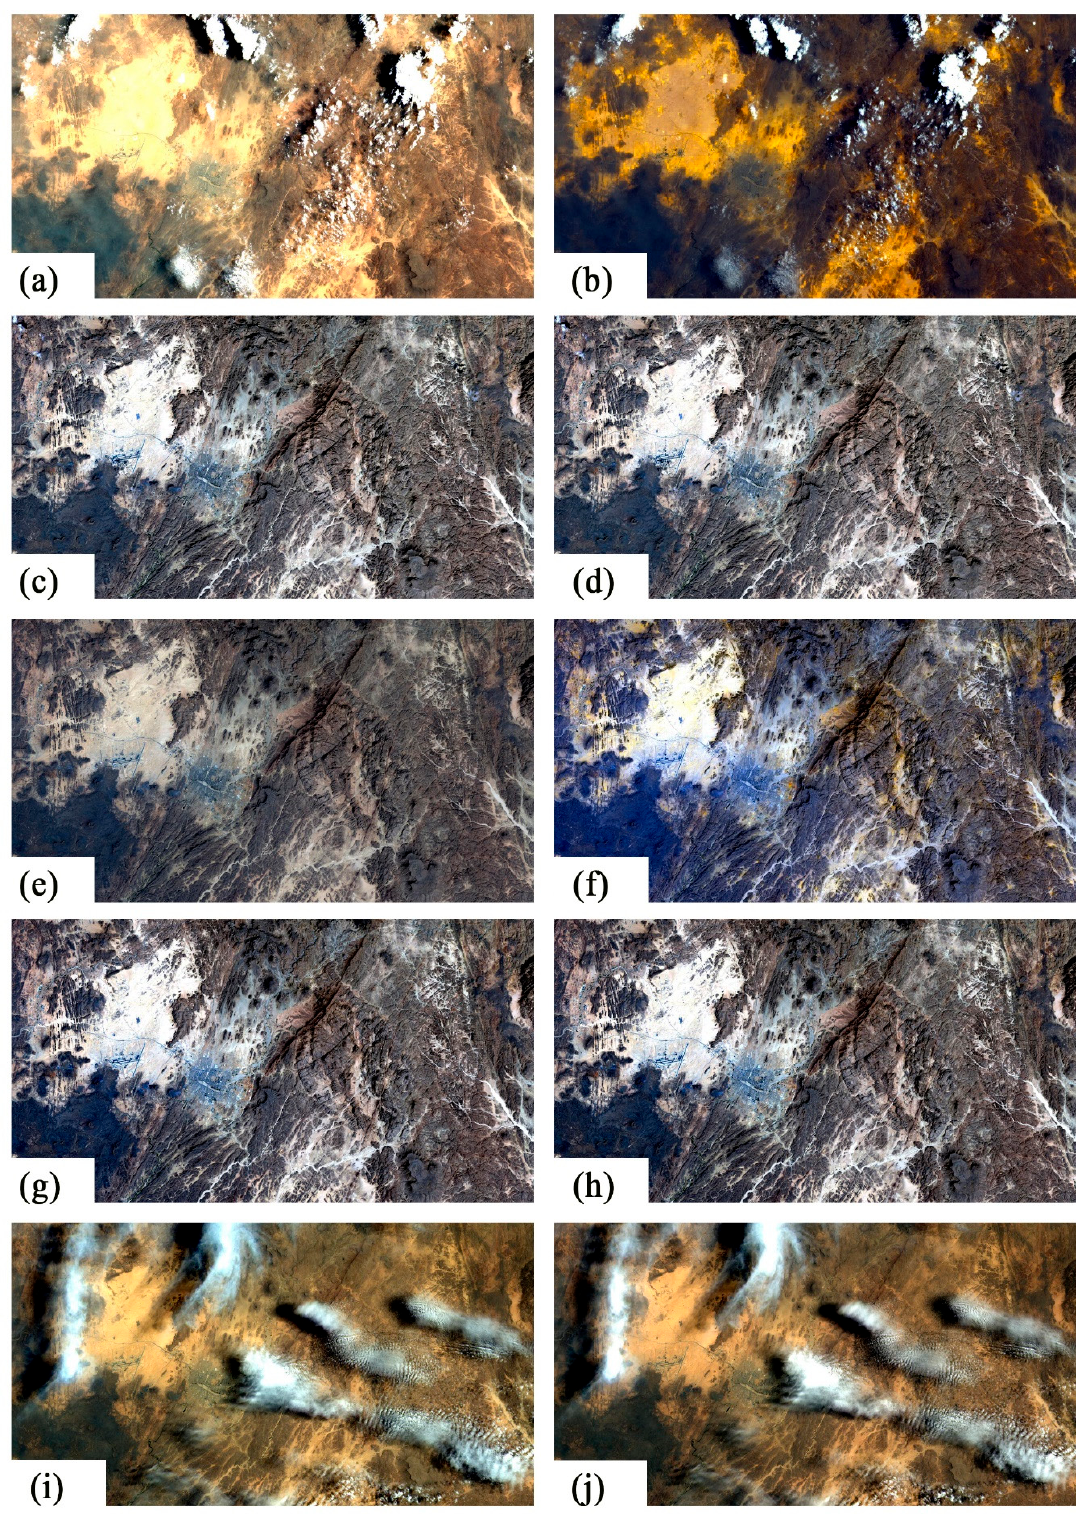
Figure 5. The atmospheric correction example for multi-temporal Landsat8 / OLI imagery at Tamanrasset_INM site. The left column is the true color composite before atmospheric correction. The right column is the true color composite after atmospheric correction. The dates of these images from top to bottom respectively are ( a , b ) 29 May 2015, ( c , d ) 1 December 2016, ( e , f ) 19 February 2017, ( g , h ) 23 March 2017, and ( i , j ) 11 June 2017.